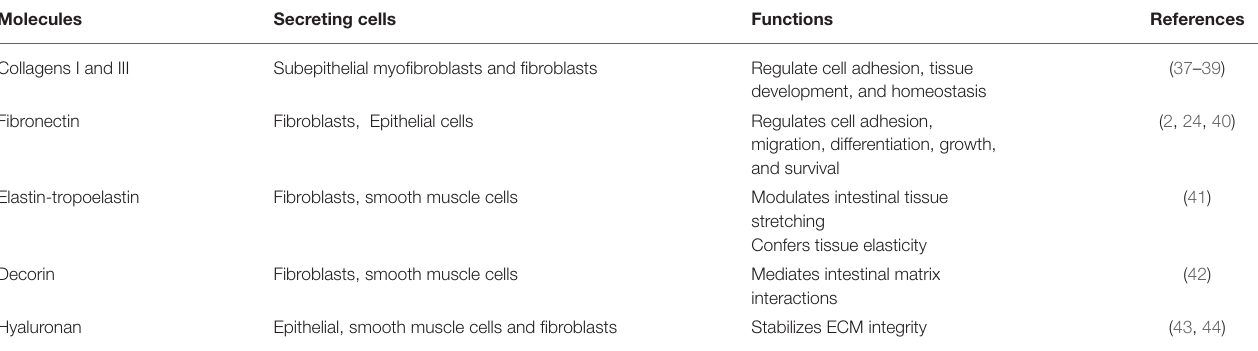
TABLE 3 | Main components of the interstitial